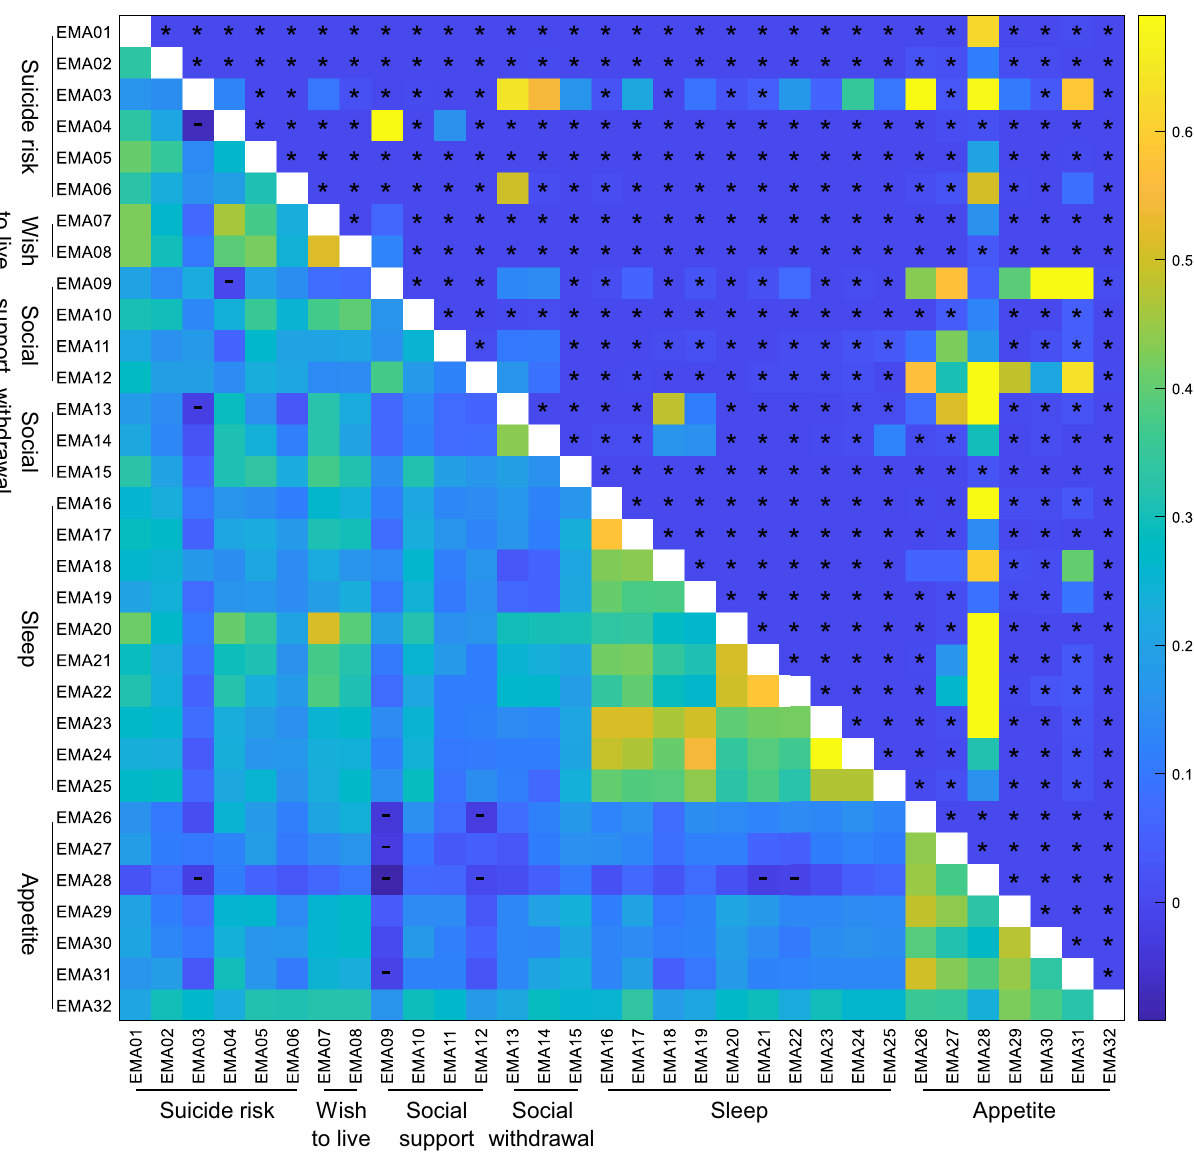
Figure 2. Correlation coefficients among the EMA questions. Correlation of the EMA questions after rescaling them from 0 to 100, where 100 represent worse health condition. Lower triangular portion: Kendall correlation coefficients; “–” for negative values. The main diagonal is intentionally empty for clarity. Upper triangular portion: P values of the hypothesis that the corresponding Kendall correlation value is 0; “*” for P values strictly lower than 0.05. The colormap on the right is used for both Kendall correlation coefficients and P values, and ranges from the overall minimum and maximum values of those